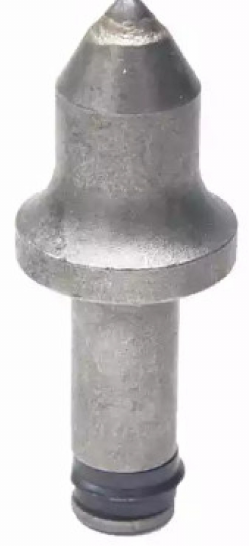
Figure 3. Shearer pick.